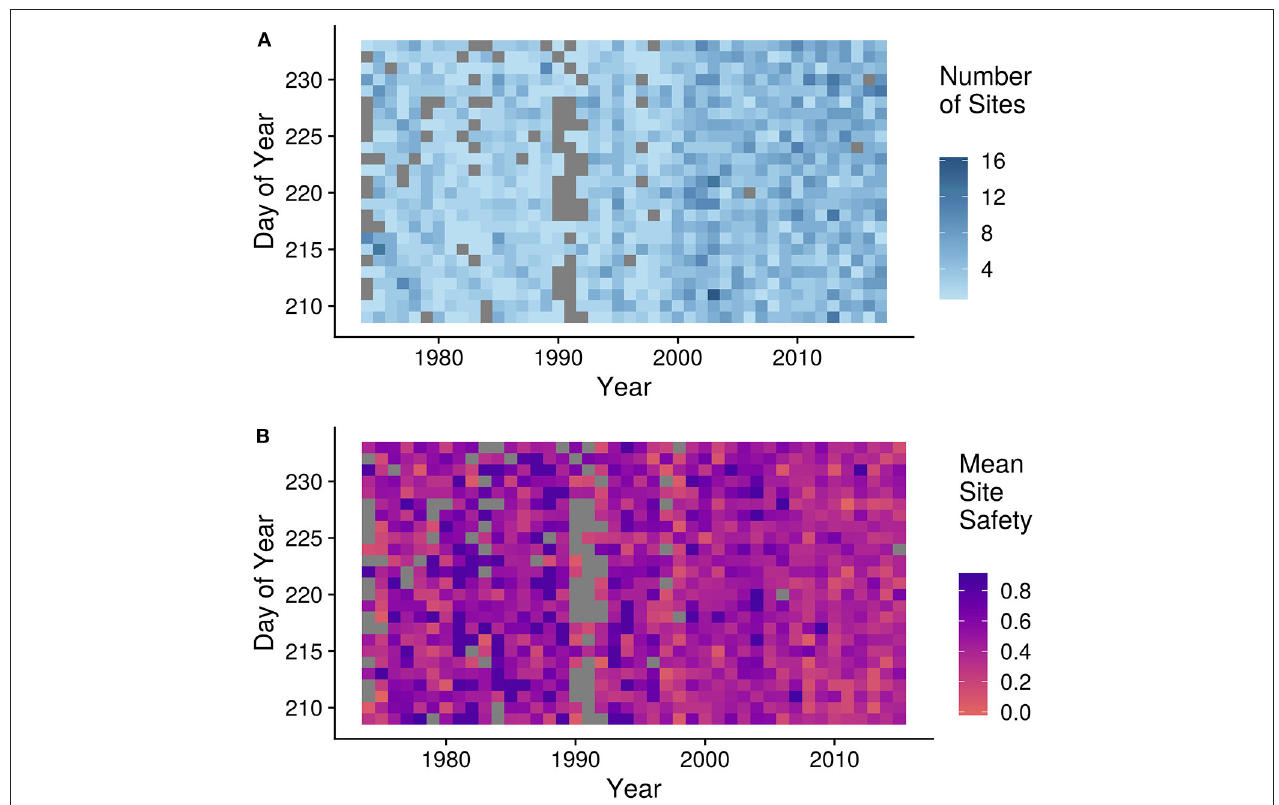
FIGURE 6 | Biases and variation in site survey effort across years and dates. (A) Number of sites surveyed in a given day across years where darker blue shows more sites surveyed on a given day of year in a year. (B) Mean safety ( y i ) of sites surveyed in a given day across years where red indicates more dangerous sites surveyed for a given day and purple shows safer sites surveyed on that day. Gray represents zero surveys in both